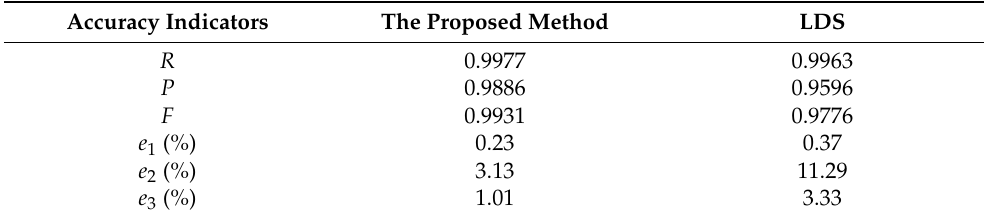
Table 1. Filter results of ICESat-2